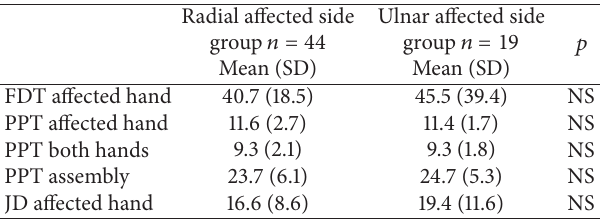
Table 4: Mean difference in FDT, PPT, and JD scores between TF participants with radial versus ulnar side affected.